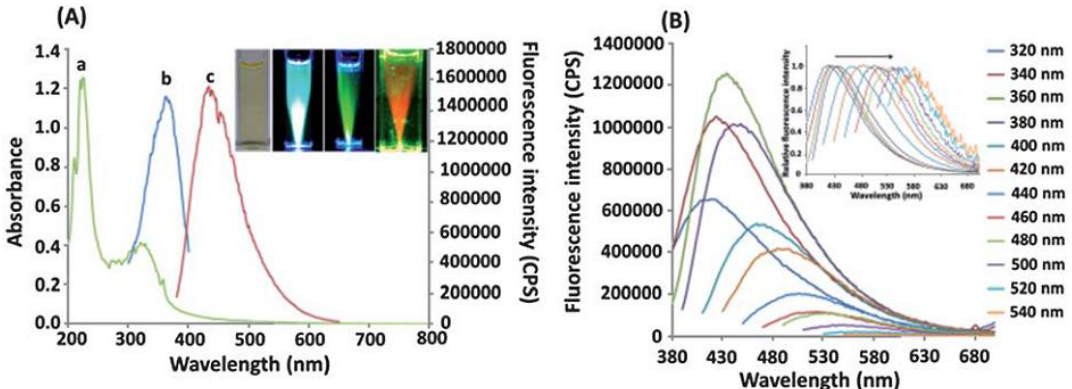
Figure 7. ( A ) Absorption (a), excitation (b) and emission spectra (c) of nitrogen-doped GQDs showing an intrinsic peroxidase-like catalytic activity. Inset: (from left to right) GQD solutions under bright light, violet, blue and green irradiation, respectively; ( B ) Luminescence emission spectra of the GQDs with different excitation wavelengths. Reproduced from [24] with permission of The Royal Society of